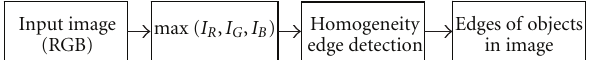
Figure 2: The homogeneity edge detection method.